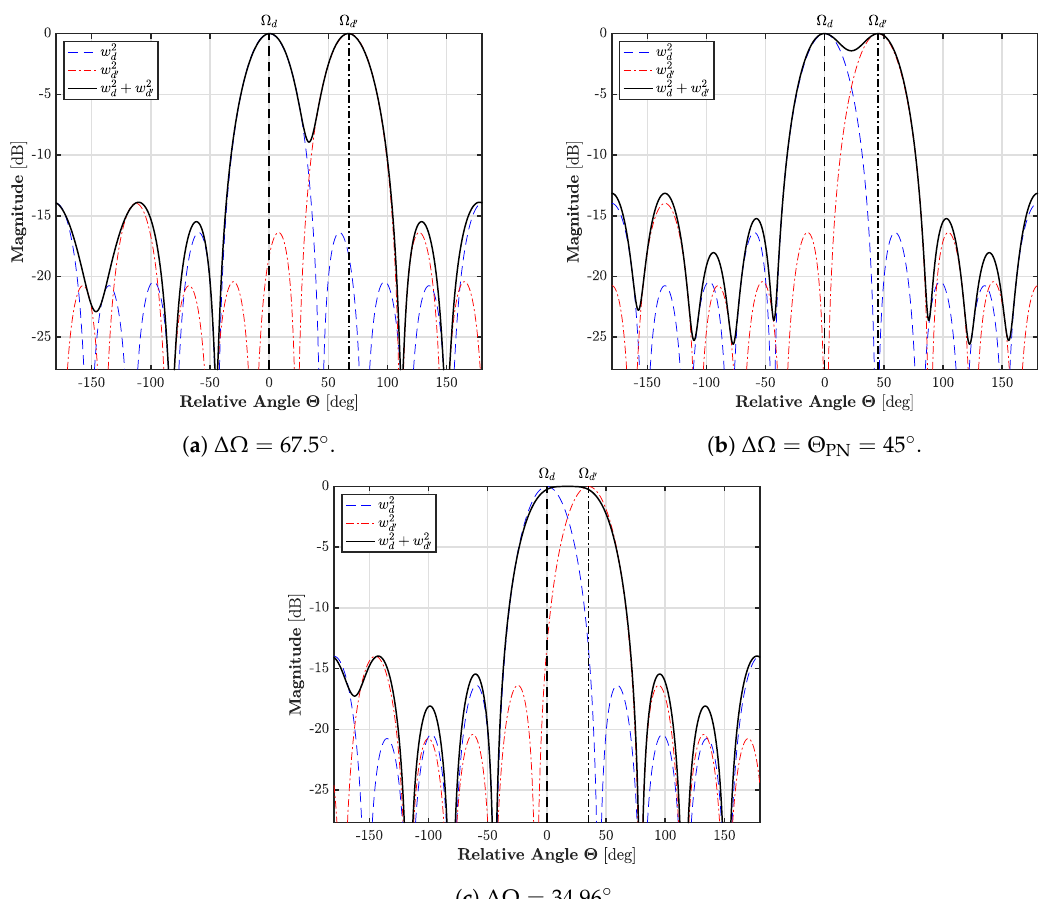
Figure 1. 4th-order combined directivity patterns for two plane-wave decomposition (PWD) directions ∆Ω apart, in terms of the relative angle Θ along the great circle joining them on the unit